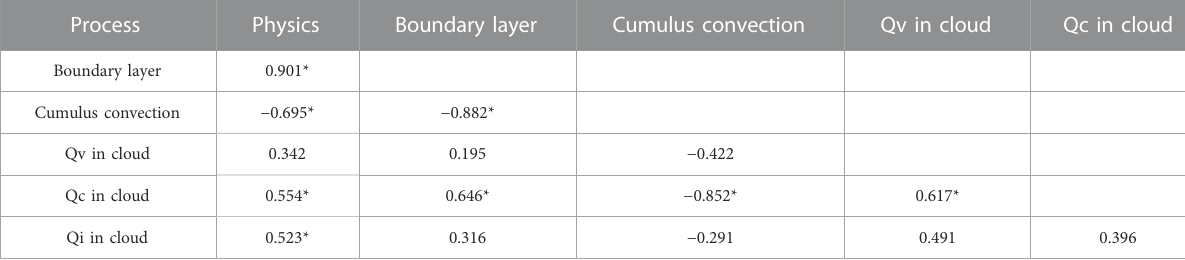
TABLE 1 Correlation coef fi cients of the vapour tendencies for each process in the summer.